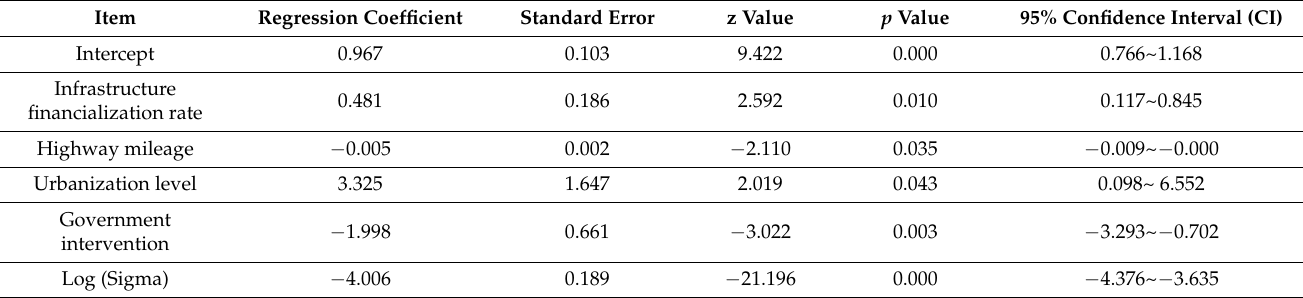
Table 4. Summary of Tobit regression analysis results (n =